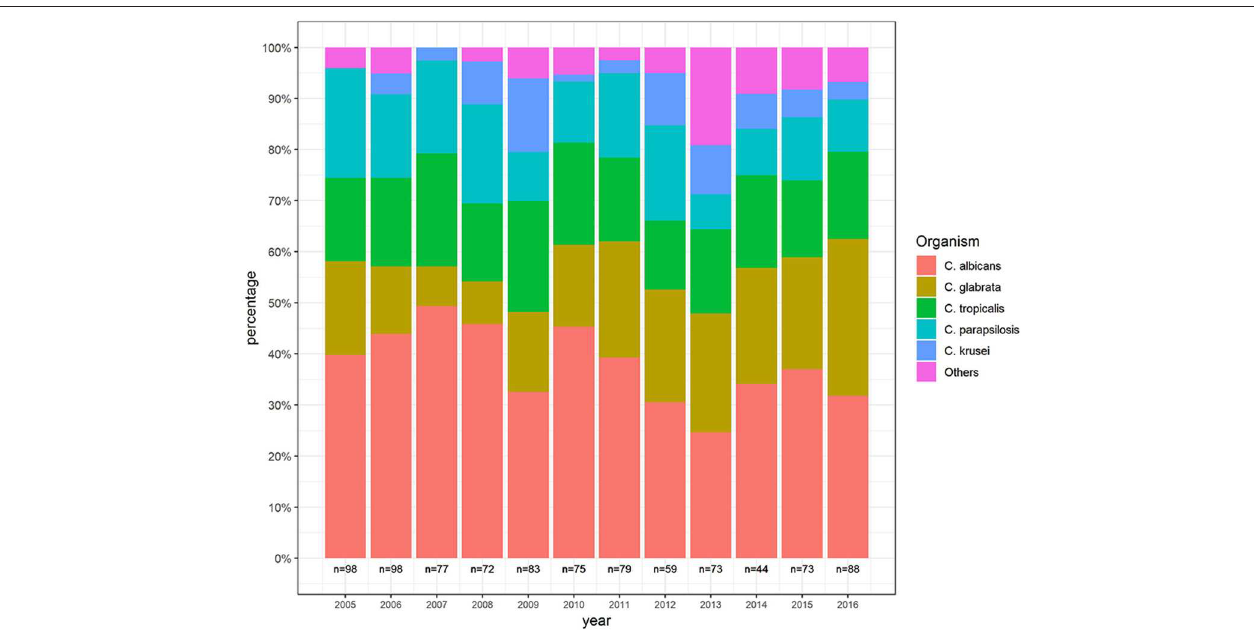
FIGURE 1 | Distribution of Candida species during the study period.